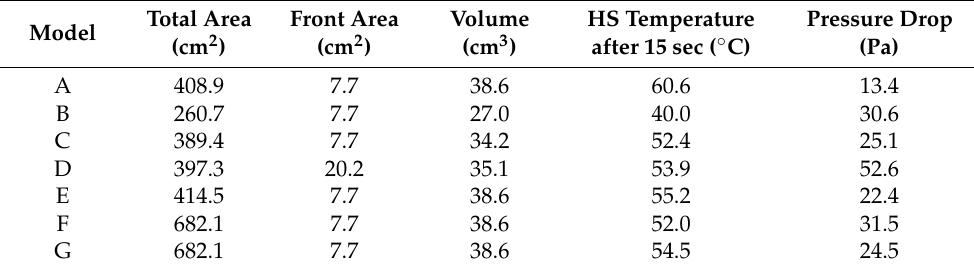
Table 6. Temperature and pressure drop for each fin heat sink